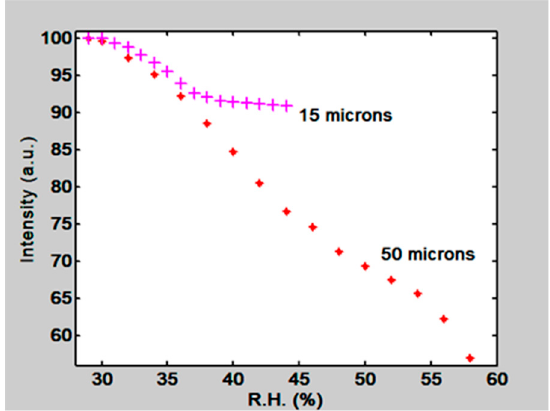
Figure 20. First order intensity as a function of RH in the climatic chamber. A PVA/PAA film with 50 µm thickness was used.